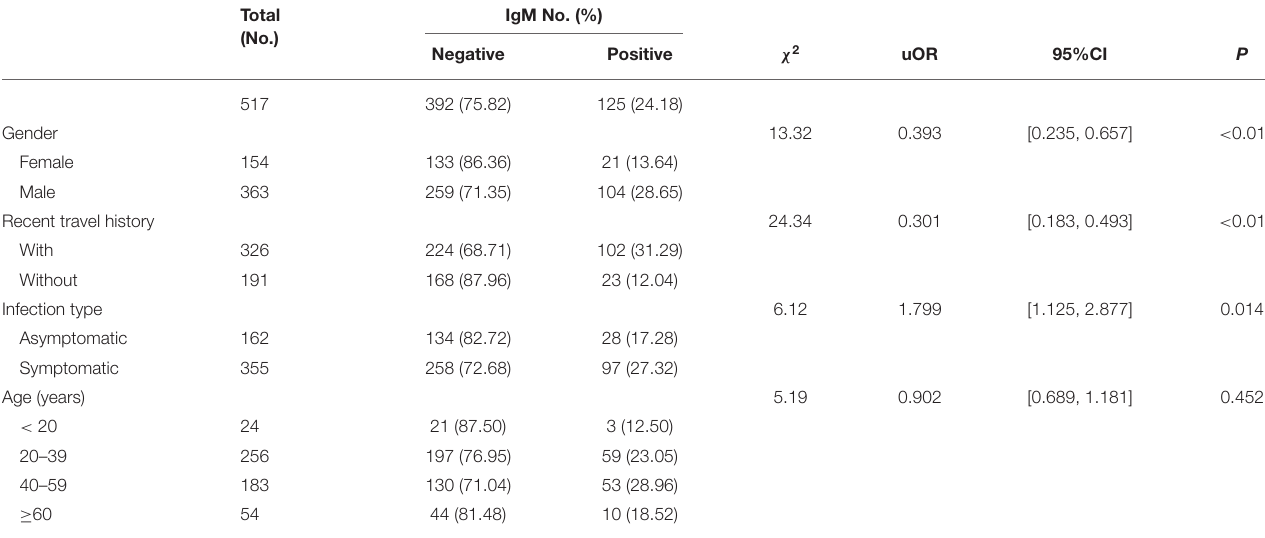
TABLE 1 | Demographic and clinical characteristics of